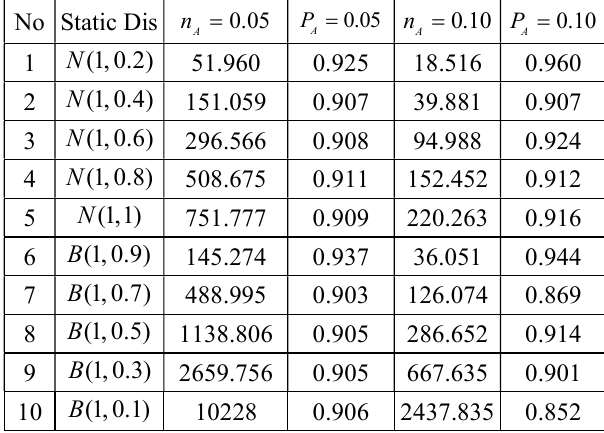
Table 2 Test result for artificial models to the extension of algorithm